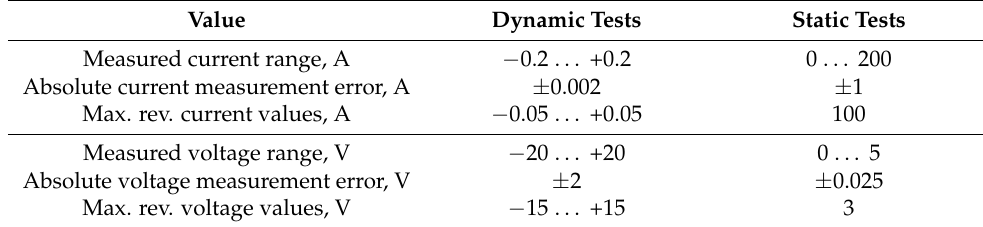
Table 1. Characteristics of the measured signals.